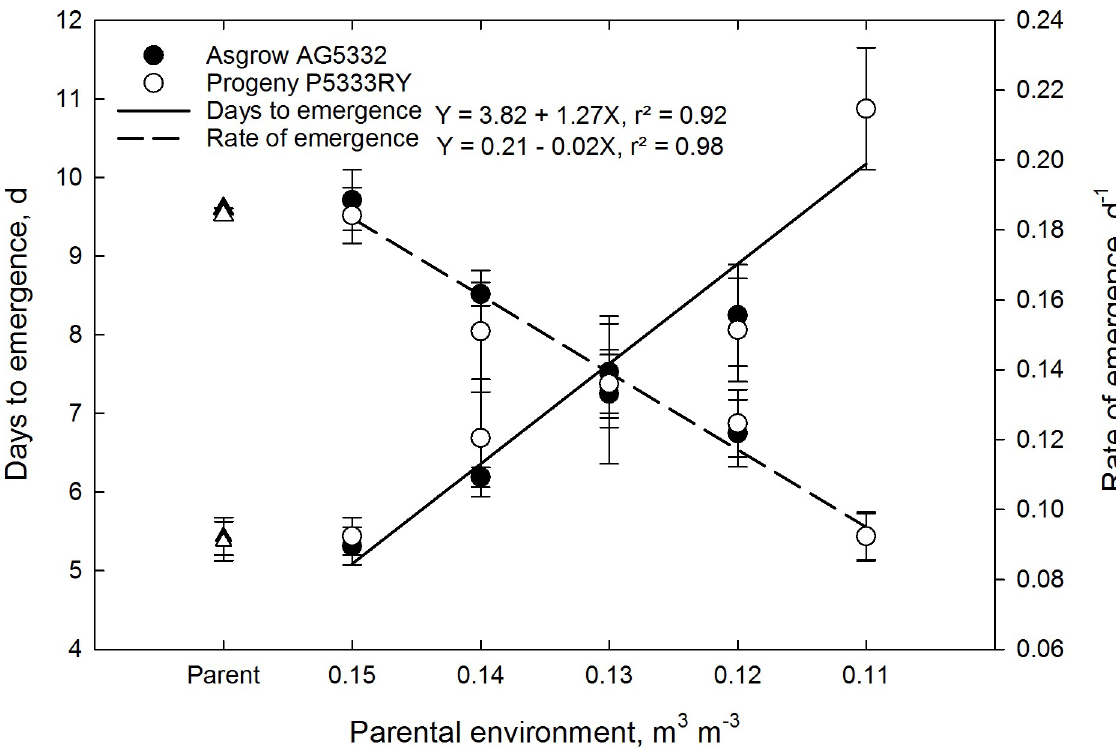
Fig 5. Days to emergence and rate of emergence for the F1 generation of soybean cultivar Asgrow AG5332 and Progeny P5333RY exposed to drought stress including replacement of 100, 80, 60, 40, and 20% of the evapotranspiration demand. Each data point is the mean of four replications pooled over cultivar, while bars represent the standard error of the mean. Lines are the best fit of a linear